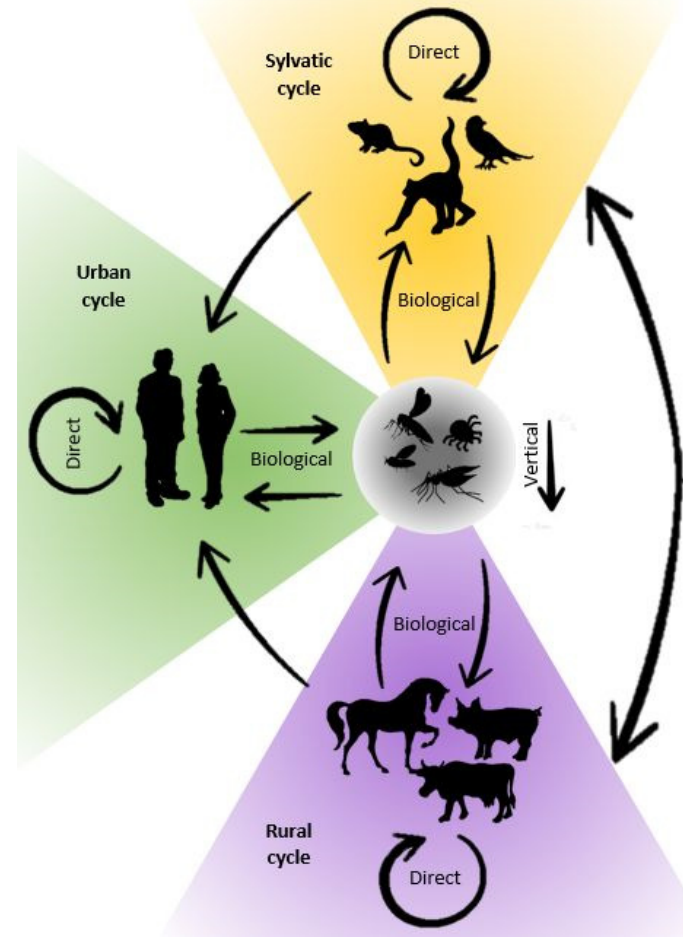
Figure 2. Environmental transmission cycles of arboviruses: sylvatic (yellow), urban (green), and rural (violet).